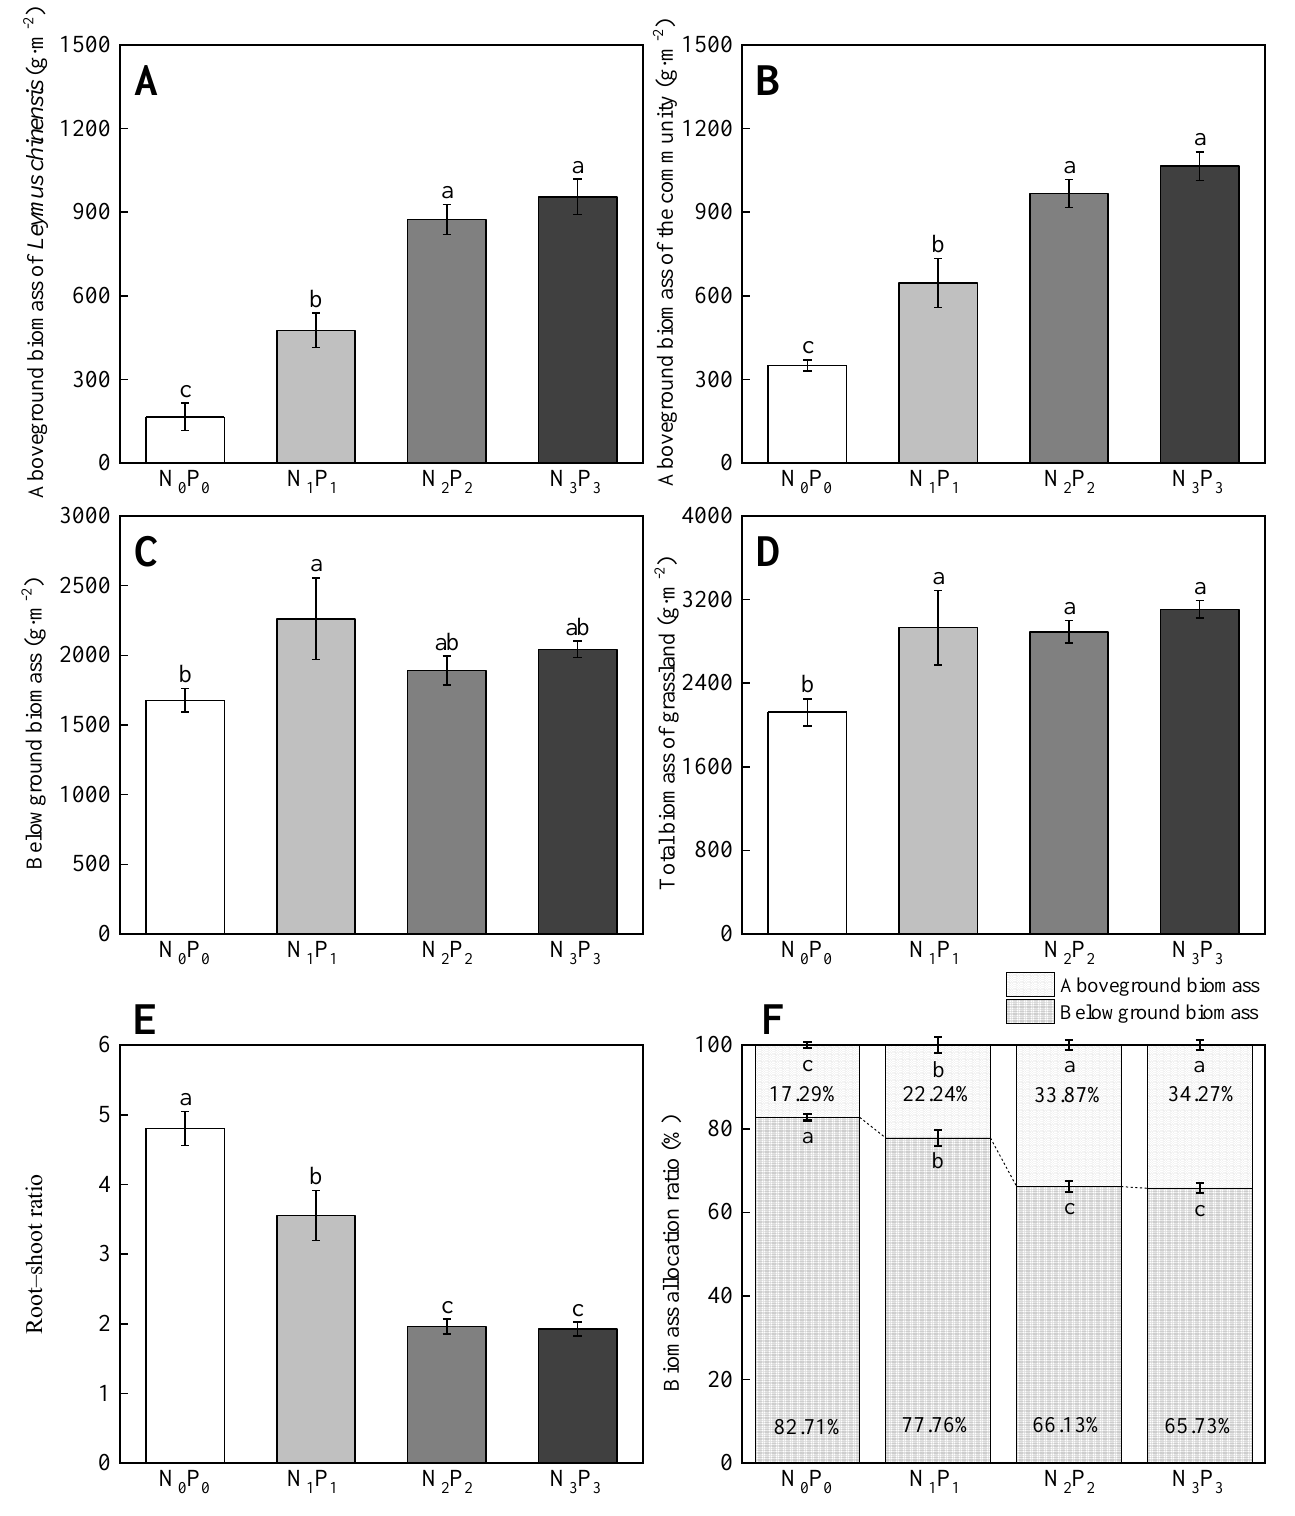
Figure 6. Changes in plant community biomass and root-to-shoot ratio after N and P addition. ( A ) Aboveground biomass of L. chinensis , ( B ) aboveground biomass of the community, ( C ) below- ground biomass in the 0–30 cm soil layer, ( D ) total biomass of grassland, ( E ) root–shoot ratio, ( F ) biomass allocation ratio. Lower case letters in the graphs indicate significant differences ( p < 0.05, LSD